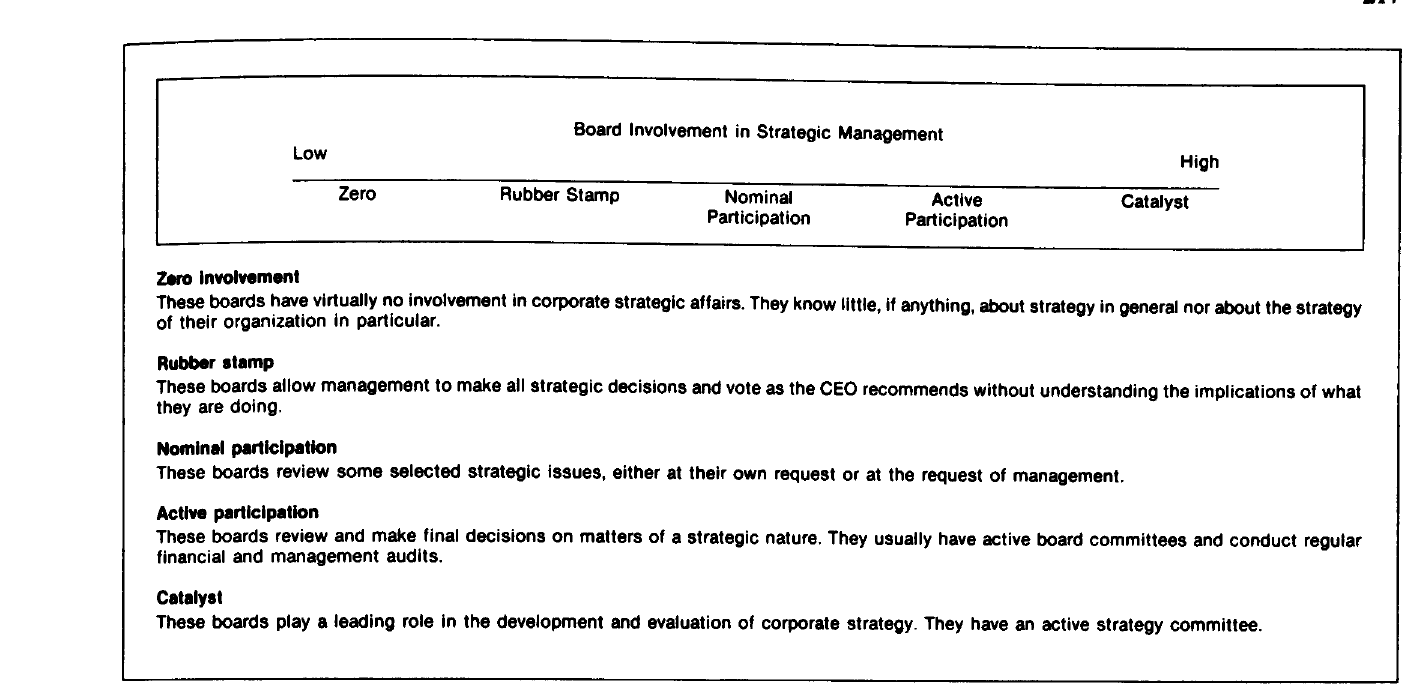
Figure 2 Degrees of board involvement in strategic management (Adapted from: Wheelen & Hunger,